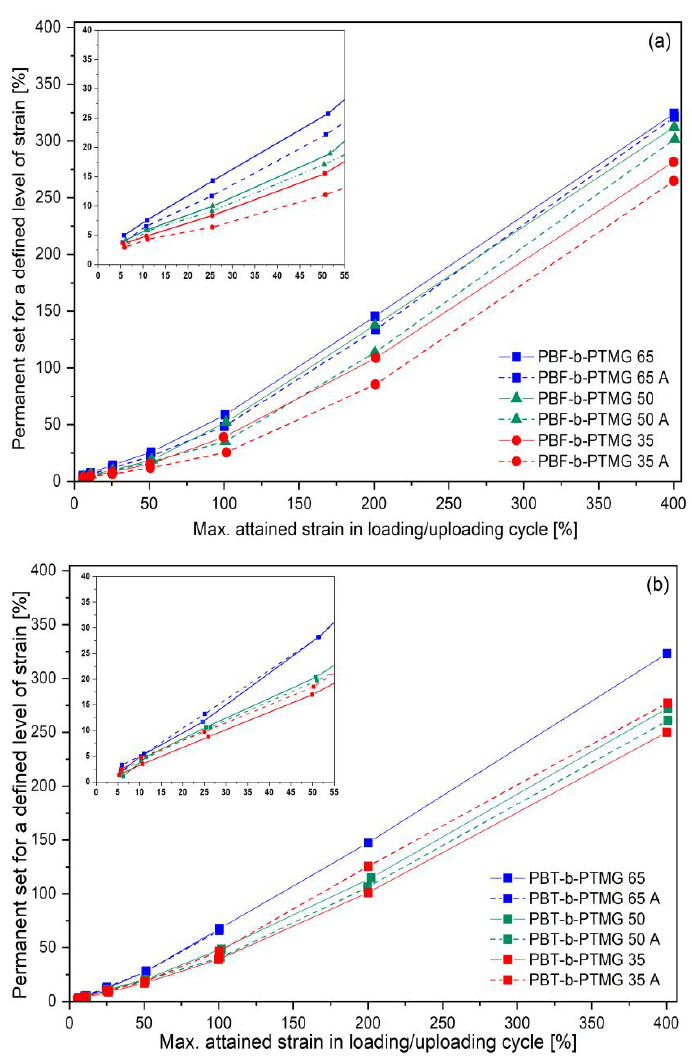
Figure 9. Permanent set values after loading/unloading cycle up to 5, 10, 25, 100, and 200% of the attained strain for PBF ( a ) and PBT ( b ) copolymers. Samples after one month of storage. Dash lines refer to annealed samples.